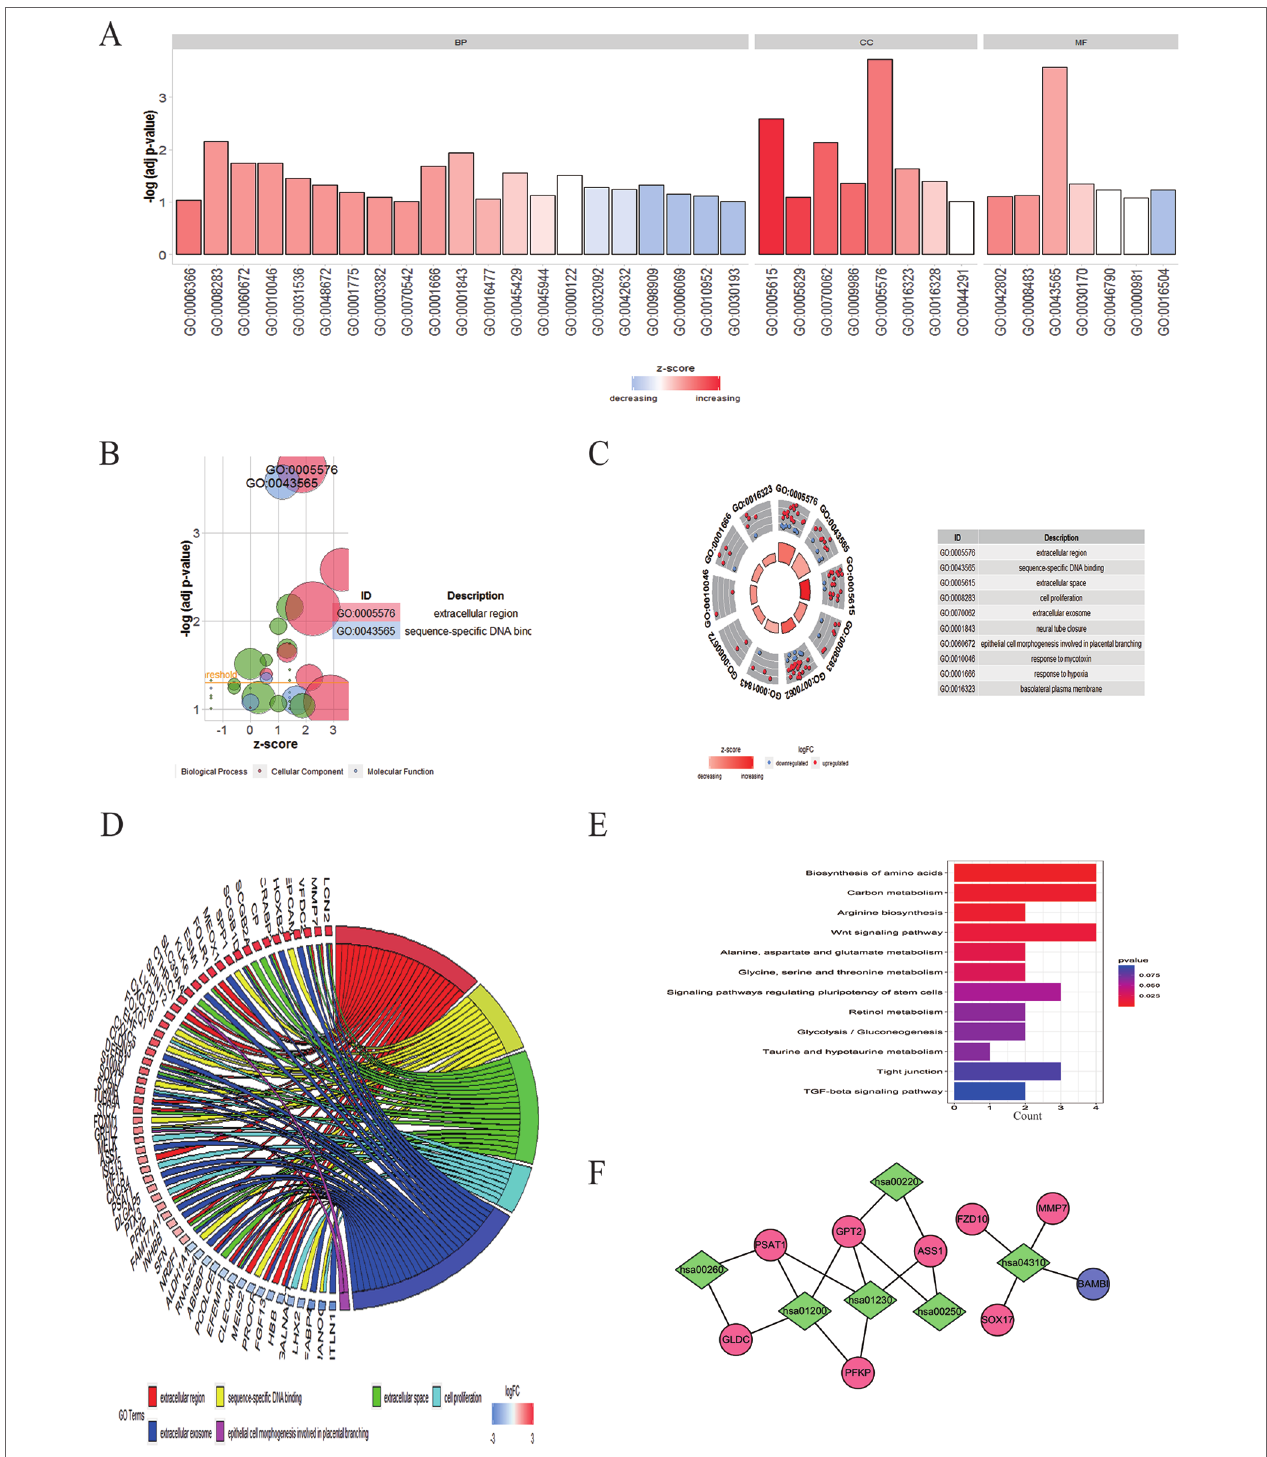
FIgUrE 3 | GO enrichment and KEGG analysis of DEGs in EOC. (A) GO analysis divided DEGs into three functional groups: molecular function, biological processes, and cell composition. (B) The bubble plot of enriched GO terms. The z -score is assigned to the x -axis, and the negative logarithm of the P value to the y -axis, as in the barplot (the higher the more significant). The size of the displayed circles is proportional to the number of genes assigned to the term. Green circles correspond to the biological process, red indicates the cellular component, and blue shows the molecular function category. (C) The top 10 GO terms of DEGs in EOC. The outer circle shows a scatter plot for each term of the logFC of the assigned genes. Red circles display upregulation and blue ones downregulation. (D) Distribution of DEGs in cervical cancer for different GO-enriched functions. (E) KEGG analysis of DEGs. (F) The pathway–protein network of DEGs.